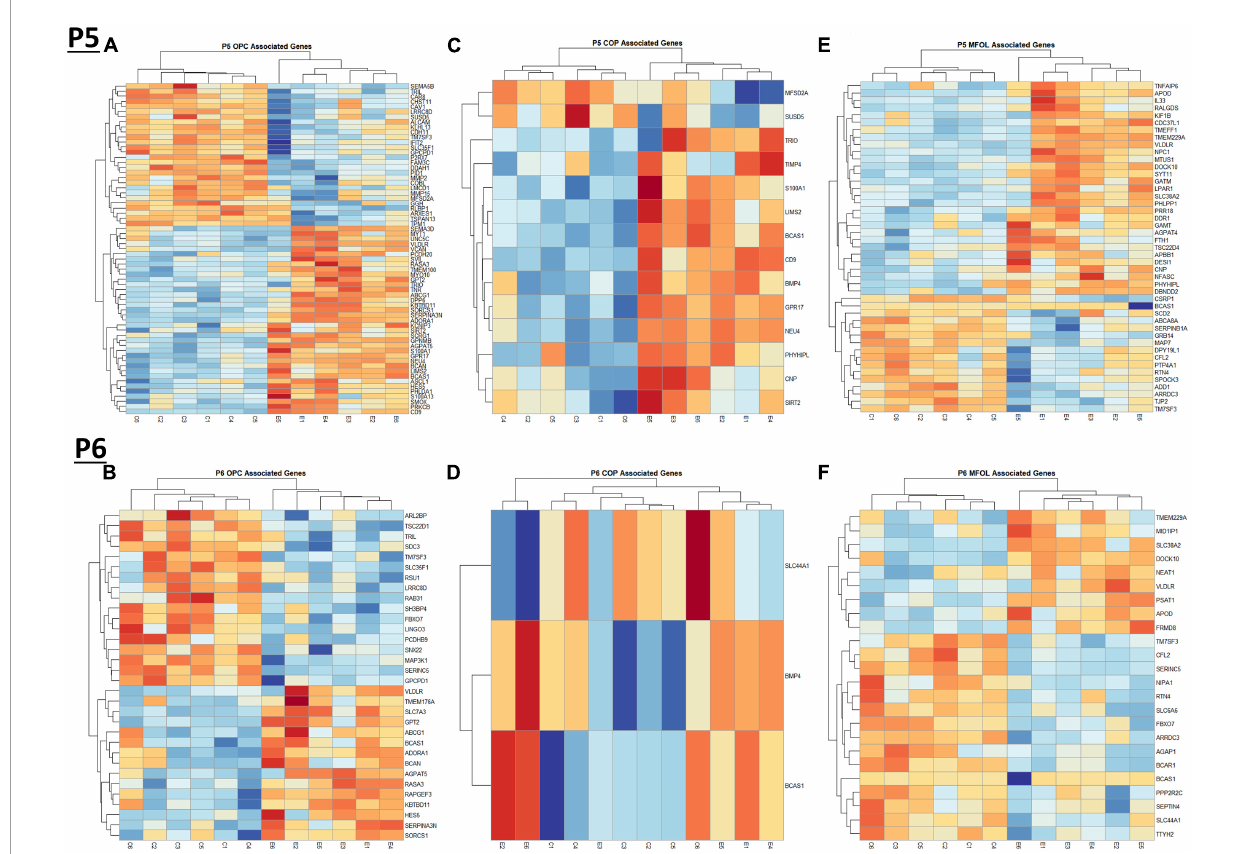
FIGURE7 Heatmap and hierarchical clustering of oligodendrocyte lineage associated genes at P5 and P6. R statistical software was utilized to construct heatmaps and hierarchical clustering dendrogram of relative gene expression across samples for significantly altered (adj. p < 0.05) and categorized oligodendrocyte lineage associated genes as detailed in Methods. OPC associated gene expression is depicted in panel (A) for P5 and panel (B) for P6. COP associated gene expression is depicted in panel (C) for P5 and panel (D) for P6. MFOL associated gene expression is depicted in panel (E) for P5 and panel (F) for